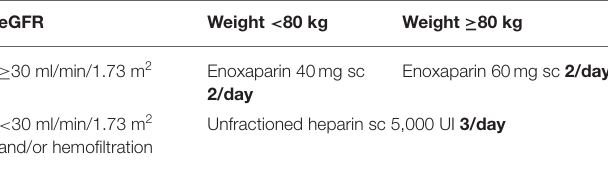
TABLE 1 | Weight and GFR adapted higher-intensity thromboprophylaxis.